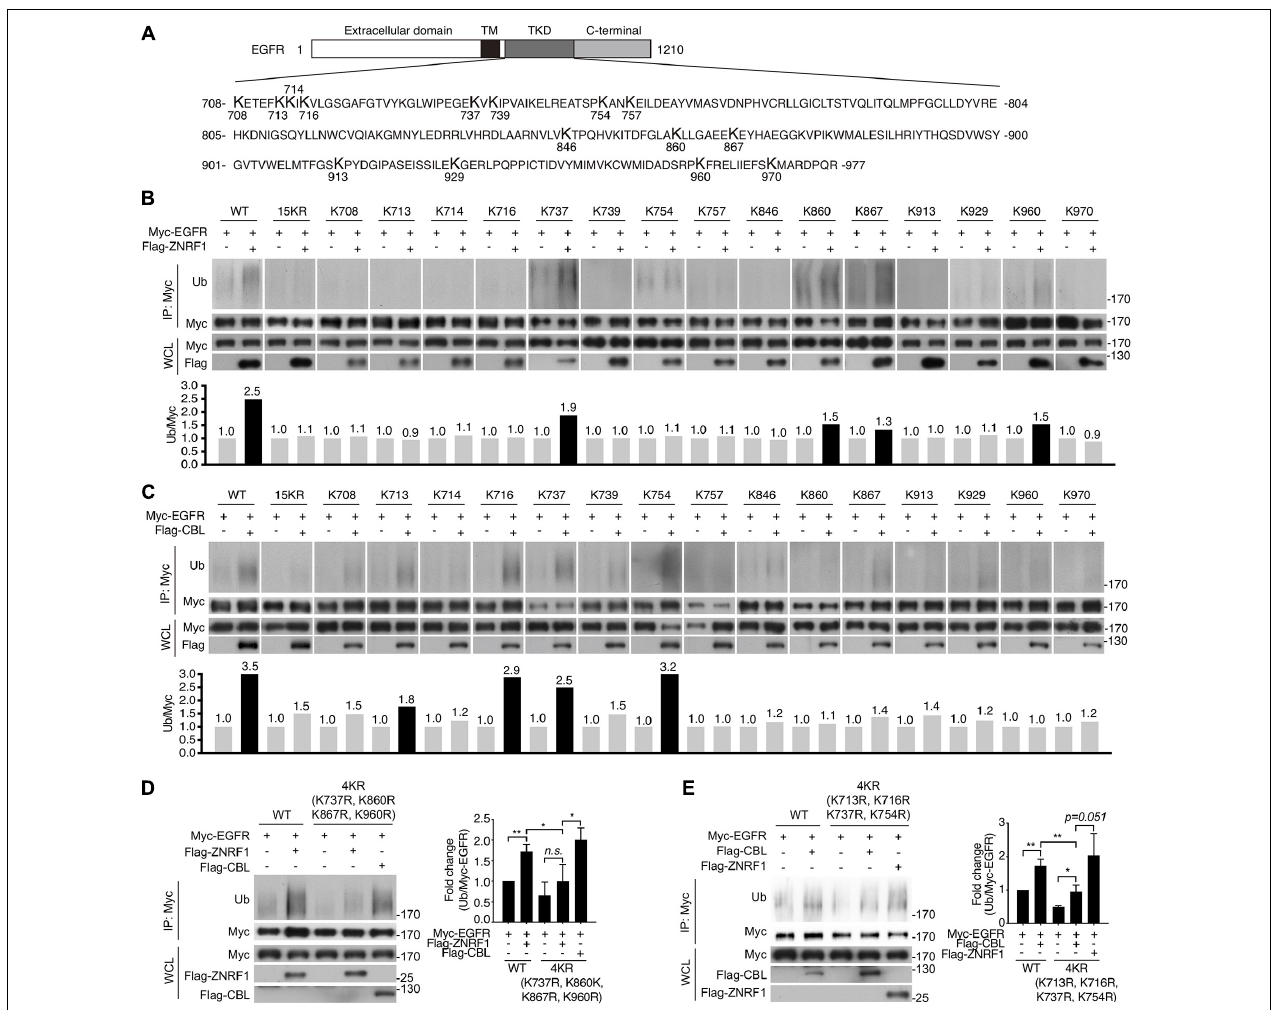
FIGURE 7 | Identification of ubiquitin-modified lysine residues on EGFR mediated by ZNRF1 and CBL in response to EGF. (A) Schematic diagram of EGFR TKD sequence and its 15 lysine residues. (B–E) HeLa cells were co-transfected with wild type or various EGFR mutants in combination with an empty vector or the E3 ubiquitin ligase ZNRF1 or CBL as indicated for 48 h. Cells were serum-starved and stimulated with 100 ng/mL EGF for 5 min. Ubiquitination of EGFR was examined by immunoprecipitation with Myc-conjugated agarose, followed by immunoblotting with anti-ubiquitin and anti-Myc antibodies. The experiments in (B,C) were repeated two times with similar results. Quantification of immunoblotting analysis data of three independent experiments are shown in the left panels of (D,E) . Results are presented as averages ± SEM. n.s., no significant; * P < 0.05, ** P < 0.01 (Student’s t